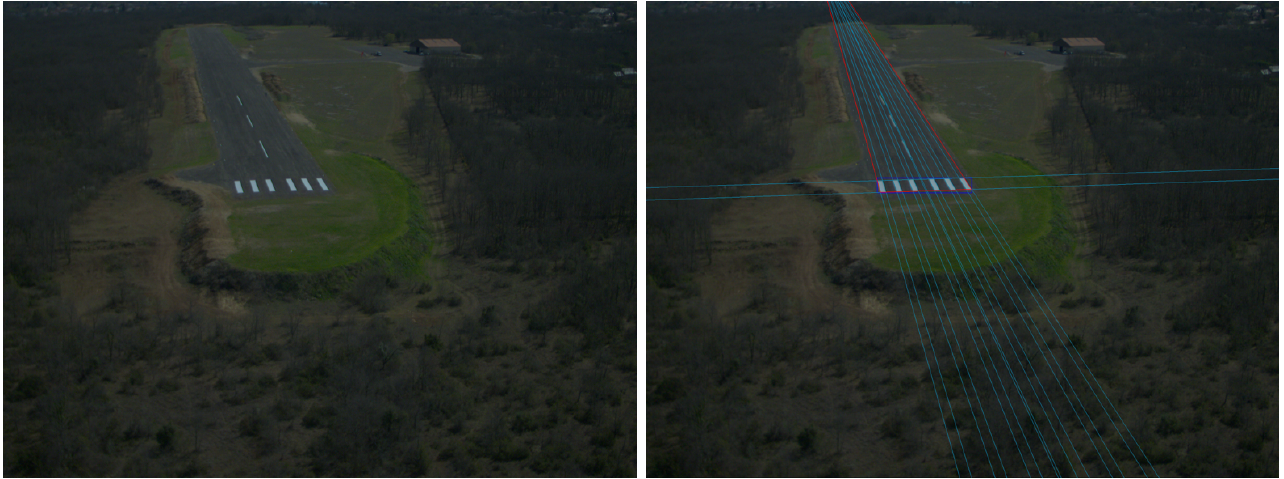
Figure 2. Original RGB image from an approach to Septfonds runway ( left ) and the output of the runway marker detection presented in the undistorted image ( right